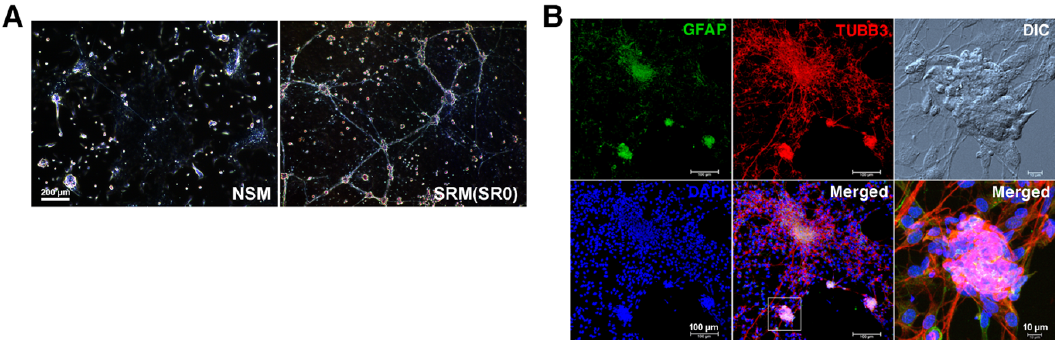
Figure 1. The formation of enteric neurospheres in NSM and SRM. Dispersed enterocytes (2 × 10 5 ) from murine fetal gut were non-adherently nurtured in 6-well plates flooded with NSR or SRM. ( A ) On day 7, enteric neurospherogenesis was photographed live under a phase-contrast microscope. SRM supported the assembly of neural networks, whereas NSM generated discrete neurospheres with the scarcity of neurite outgrowth. ( B ) Neural networks assembled from dispersed enterocytes on coverslips in SRM-filled wells were subjected to immunofluorescence staining. The neurospheres, composed of TUBB3 + neurons and GFAP + gliocytes, were structurally and morphologically linked to enteric ganglia and wired together by neuronal neurites to form neural networks (ganglionated plexuses). DIC: Differential interference contrast. SR0: Original SRM that contained CEE.